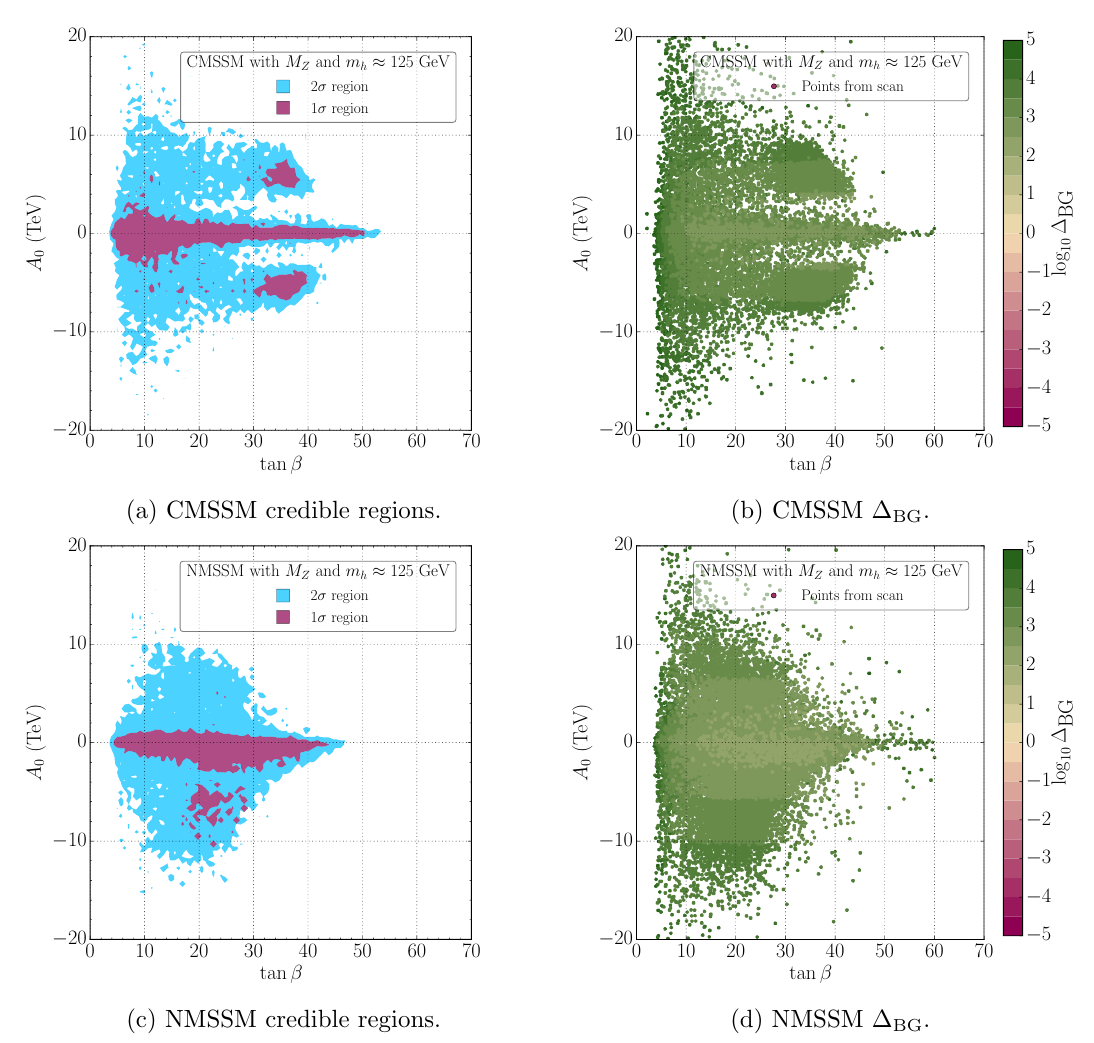
Figure 6. Credible regions of the marginalized posterior probability density conditioned upon M Z and m h (left) and pro(cid:12)led BGEN measure (right) for the CMSSM (upper) and NMSSM (lower) on the (tan (cid:12) , A 0 )